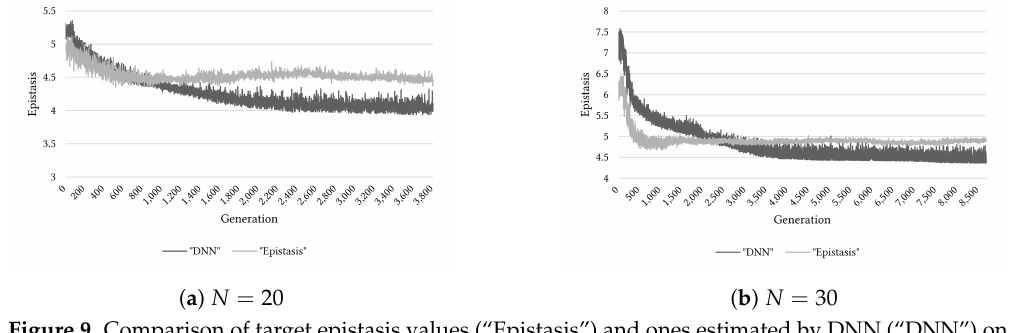
Figure 9. Comparison of target epistasis values (“Epistasis”) and ones estimated by DNN (“DNN”) on the Variant-OneMax problem.